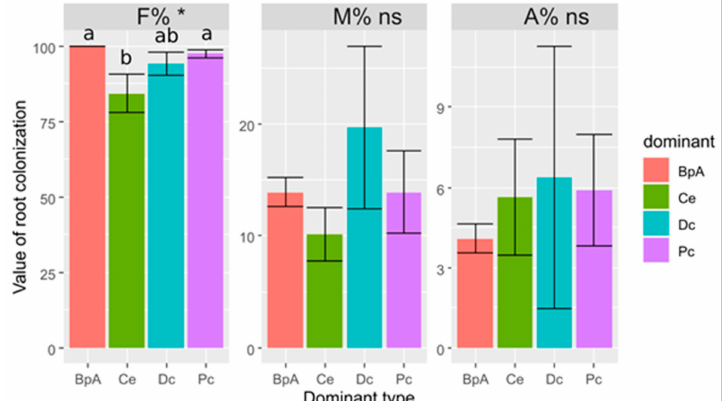
Figure 1. The mycorrhizal parameters (Mean ± SE) in the root system of Poa compressa in the vegetation patches dominated by Pc— Poa compressa , Ce— Calamagrostis epigejos , Dc— Daucus carota , and BpA— Betula pendula tree individuals. Results of ANOVA: ns—non-significant, * p < 0.05. The various letters above bars denote the significance of differences at p < 0.05 after LSD